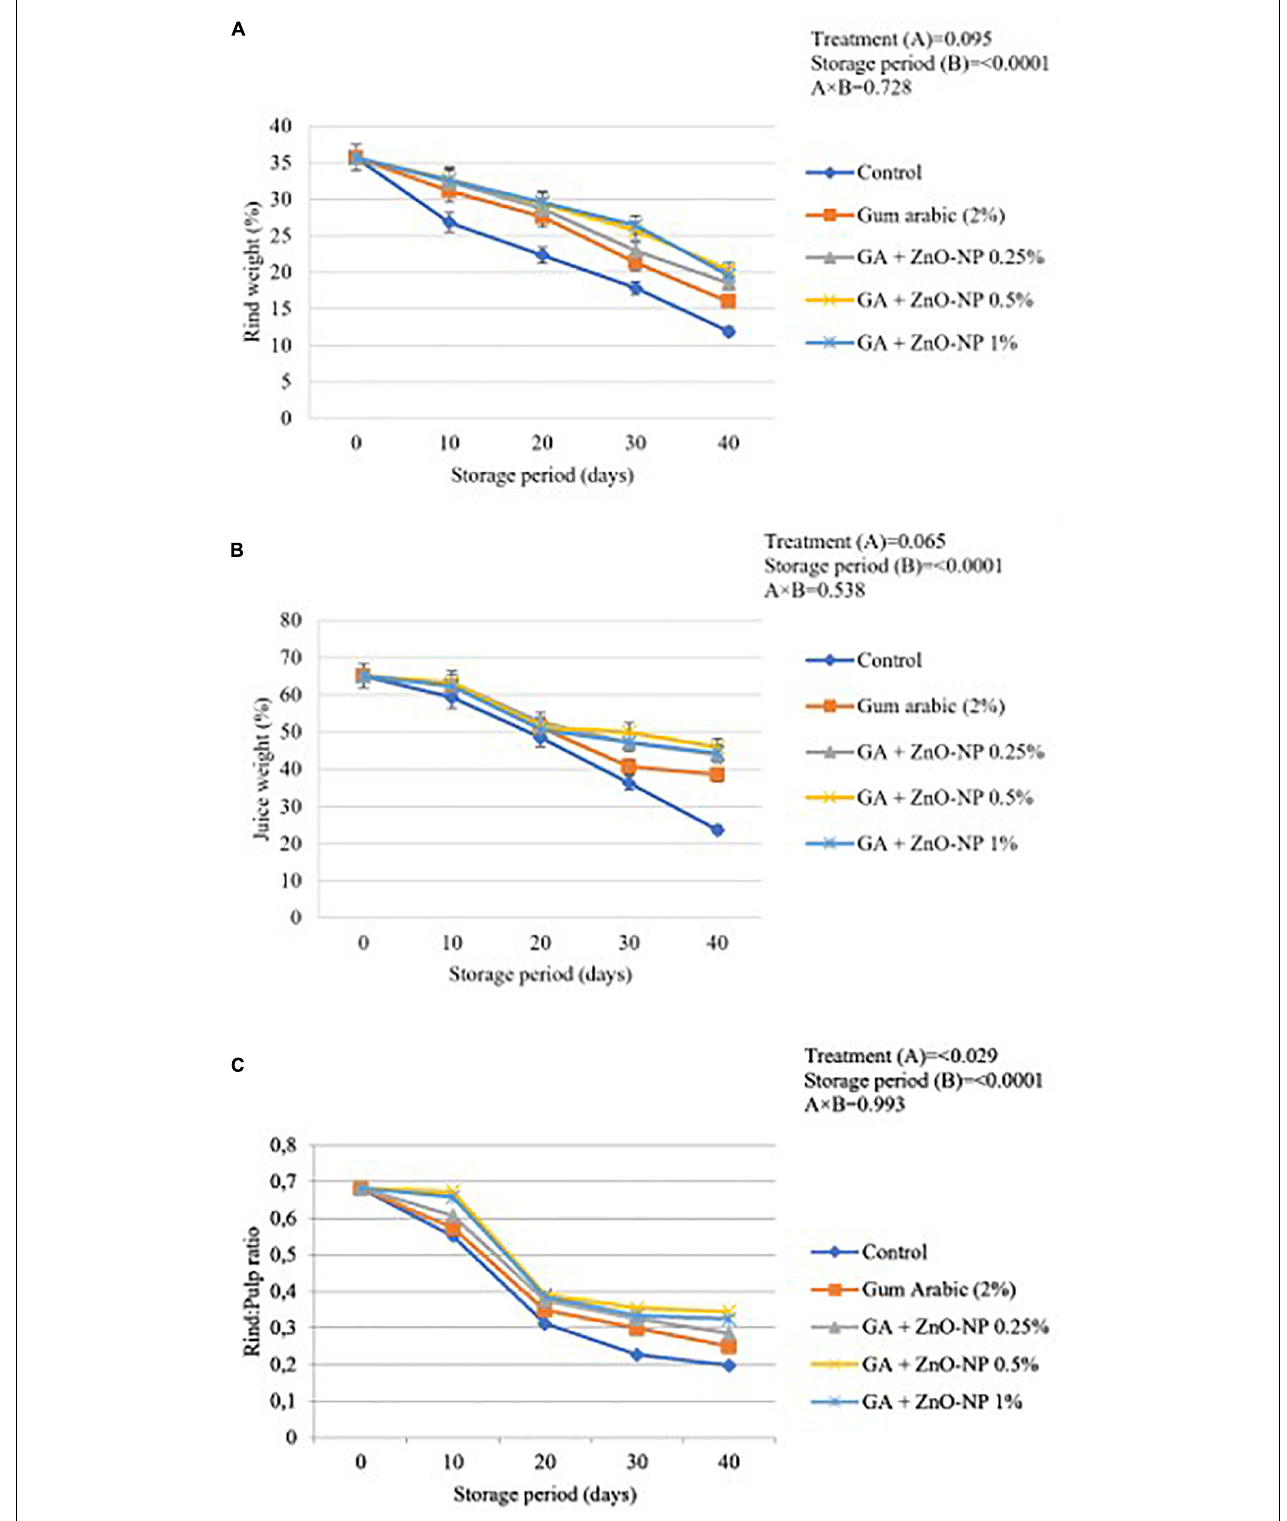
FIGURE 6 | (A) Changes in rind weight loss, (B) juice weight, and (C) rind: pulp ratio of ‘Kinnow’ mandarin fruit during storage for 40 days at 5 ± 1 ◦ C. Error bars denote the standard error (SE) of the mean. Means ± standard errors presented. To determine the interaction effects, factorial ANOVA was performed for the main factors, treatment, and storage time. GA + ZnO-NP, gum arabic + zinc-oxide nanoparticles.